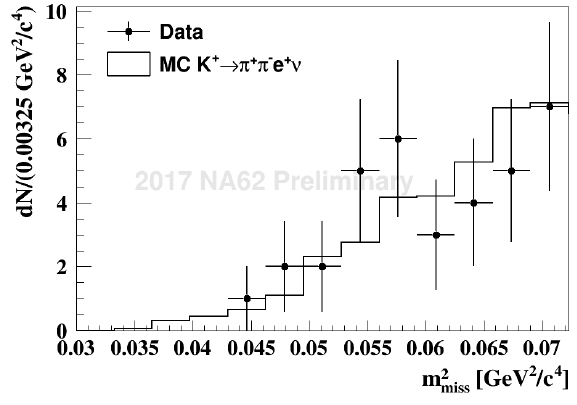
Figure 6. Distribution of m 2 K + → π + π − e + ν